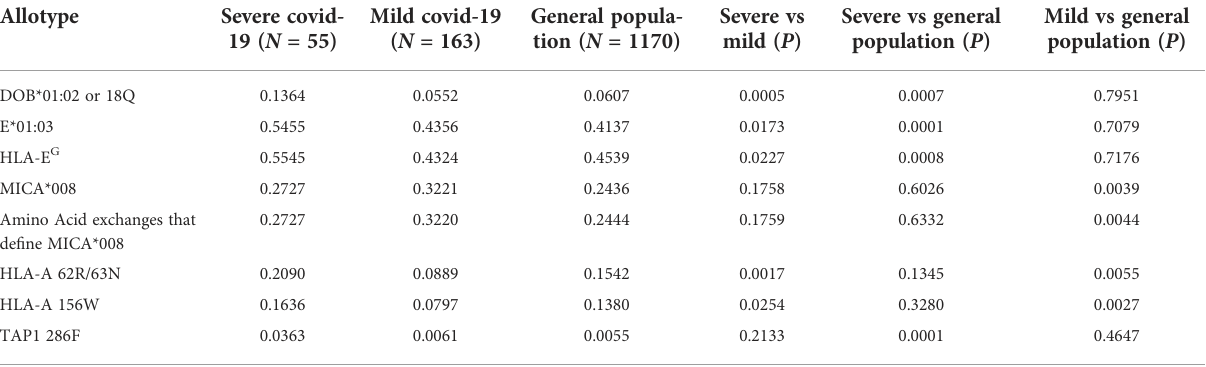
TABLE 2 MHC allotypes and amino acid residues associated with Covid-19 disease severity in